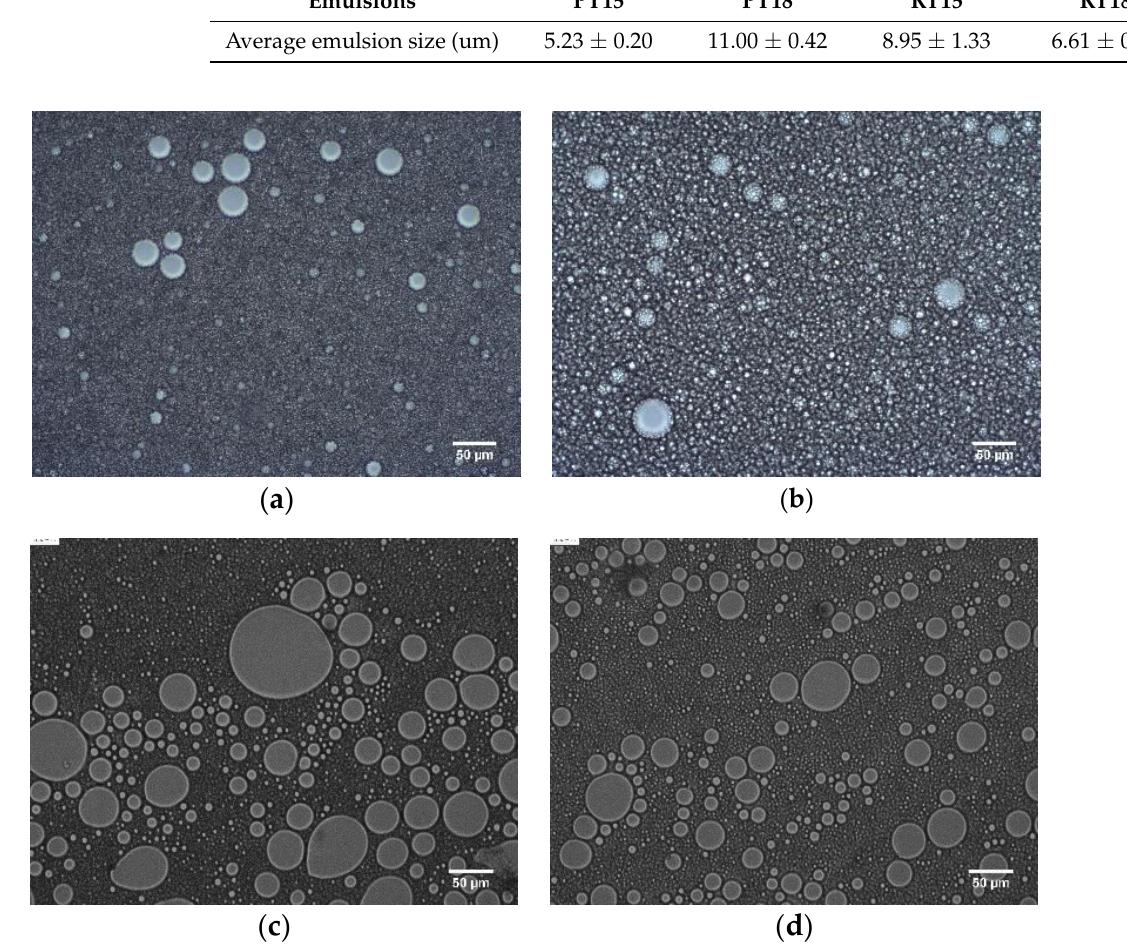
Figure 4. Optical microscopy images of ( a ) PT15, ( b ) PT18, ( c ) RT15 and ( d ) RT18 emulsions. Table 3. Average droplet size for PT15, PT18, RT15, and RT18 water emulsions. Four PCMs selected for the study were encapsulated as PVA emulsions forming the core of the PCM electrospun fiber matrix, which was encapsulated in a PCL shell. The samples of the electrospun PCM fibers were tested in the temperature range of − 30 to 80 ◦ C with a scanning rate of 1.5 ◦ C/min in dynamic mode. The mass of each sample was about 3 mg. The expanded uncertainty for each experimental measurement was ± 0.1%. Figure 5 and Table 4 show the DSC thermographs and analysis results for electrospun PCM fibers of PT15, PT18, RT15, and RT18 in the 1st thermal cycle. Figures 6–8 depict the morphology of the PCM electrospun fiber matrices. The fiber shell was formed with either 9% w / v or 12% w / v PCL. The encapsulation ratio n is shown in Table